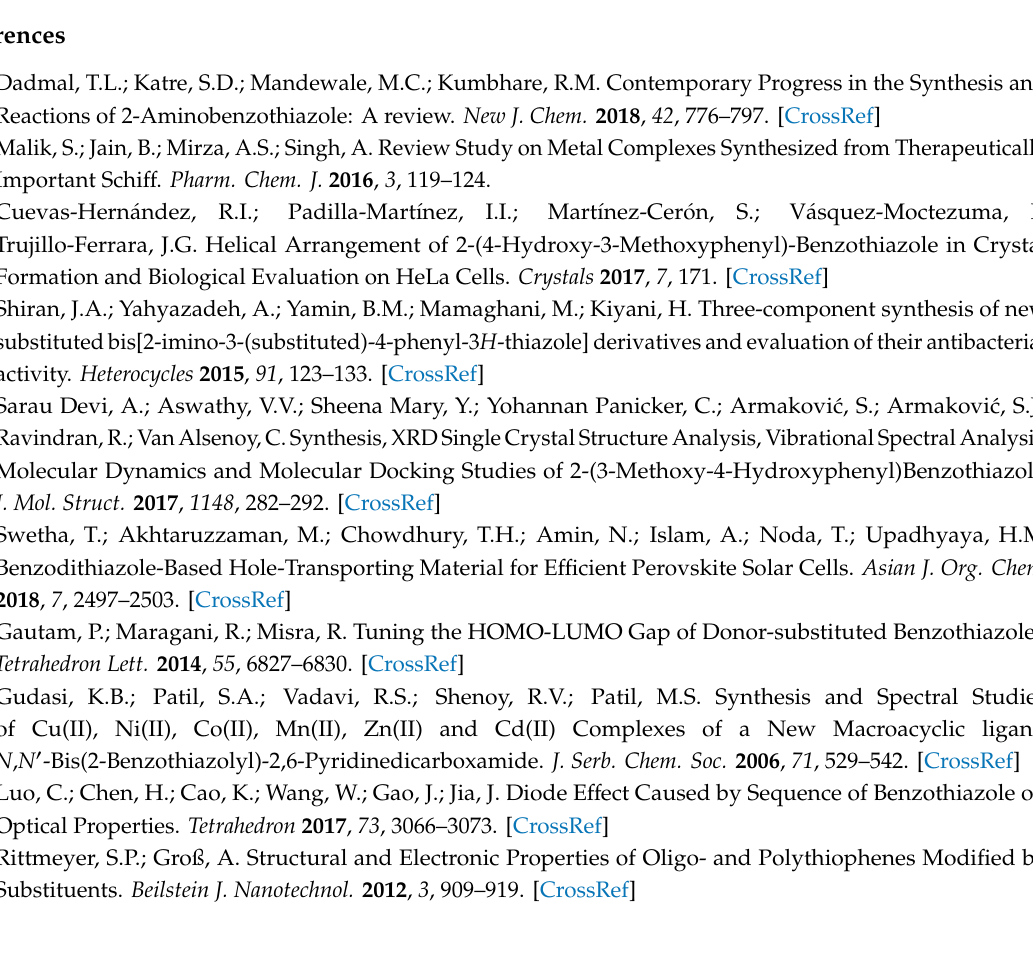
Figure S1: Interaction energies for a 3.8 Å cluster around IA, Figure S2: Interaction energies for a 3.8 Å cluster around IB, Figure S3: Interaction energies for a 3.8 Å cluster around